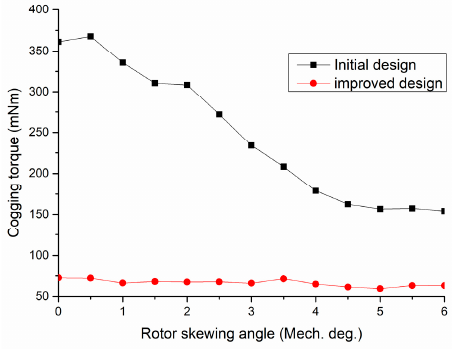
Figure 11. Cogging torque comparison.